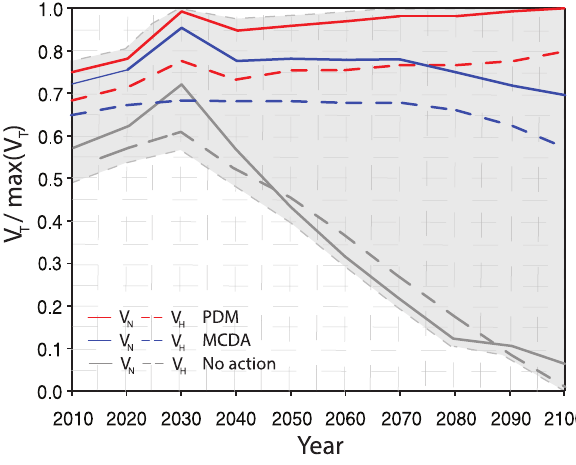
Figure 6. Global value disentangled into expected human and natural value of optimal restoration plans for the MCDA and PDM. The expected natural and human values (Eq. 2) are calculated by considering the vulnerability of human and natural assets given a restoration plan for the whole ecosystem and the effectiveness of each restoration intervention for each asset. The curves are shown for a budget of 250 units. We selected the Pareto set for which V H (R)=0.5 V N (R). Grey dashed lines represent the variability of the patterns related to thirty Monte Carlo simulations generated by considering a random white noise in the MCDA value.